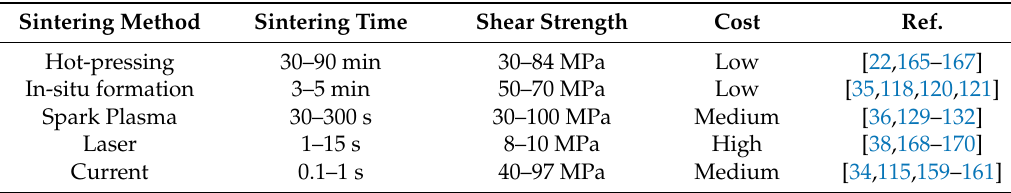
Table 1. Comparison of different rapid sintering methods.